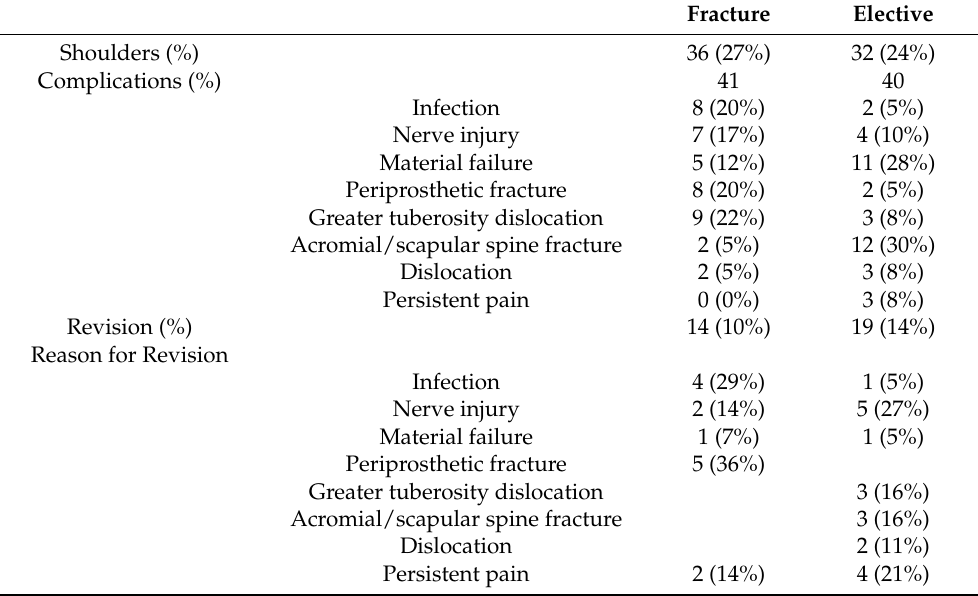
Table 4. Detailed description of complication and revision